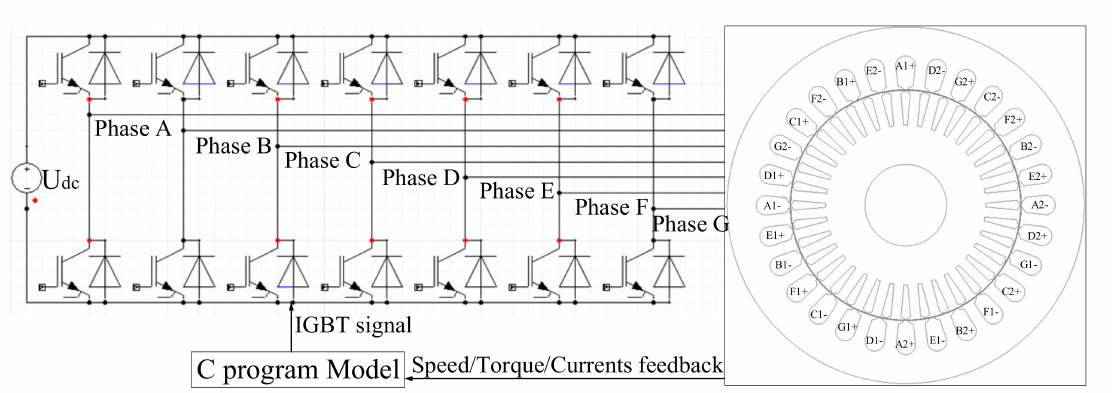
Figure 2. Field − circuit coupling FE